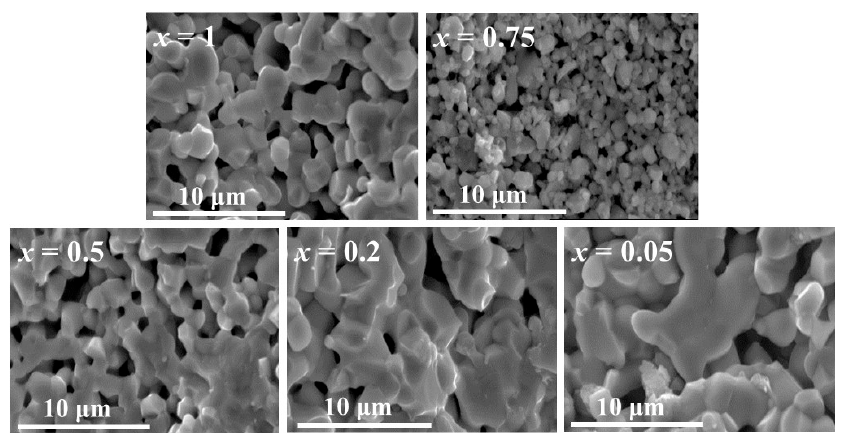
Table 1. Cell parameters, cell volume, bulk density, thermal expansion coefficient, activation energy and pre-exponential factor of electric conductivity, and figure of merit of sintered Ca 3 Co 2 − x Mn x O 6 materials with different Mn content ( x ).